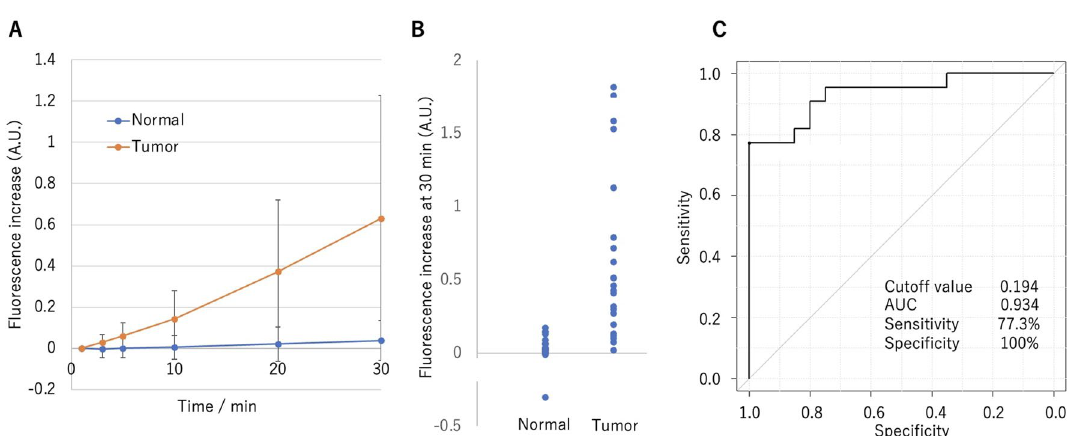
Figure 2. The outcome of ex vivo fluorescence imaging of twenty cases. ( A ) Time-dependent fluorescence increase, calculated as the increase at 30 min from 1 min after addition of gGlu-HMRG. Error bars represent s.d. ( B ) Dot plot of fluorescence increase at 30 min of normal and tumor lesions. ( C ) Receiver operating characteristic curve for all twenty cases. The cutoff value, sensitivity, and specificity of gGlu-HMRG for detection of thymic tumor were calculated for all 20 cases. Sensitivity and specificity were 77.3% and 100%, respectively. AUC, area under